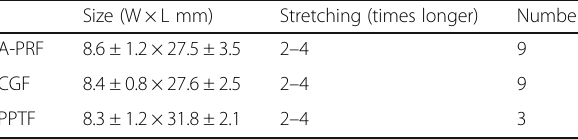
Table 1 Similarity in size and stretching property of A-PRF and CGF